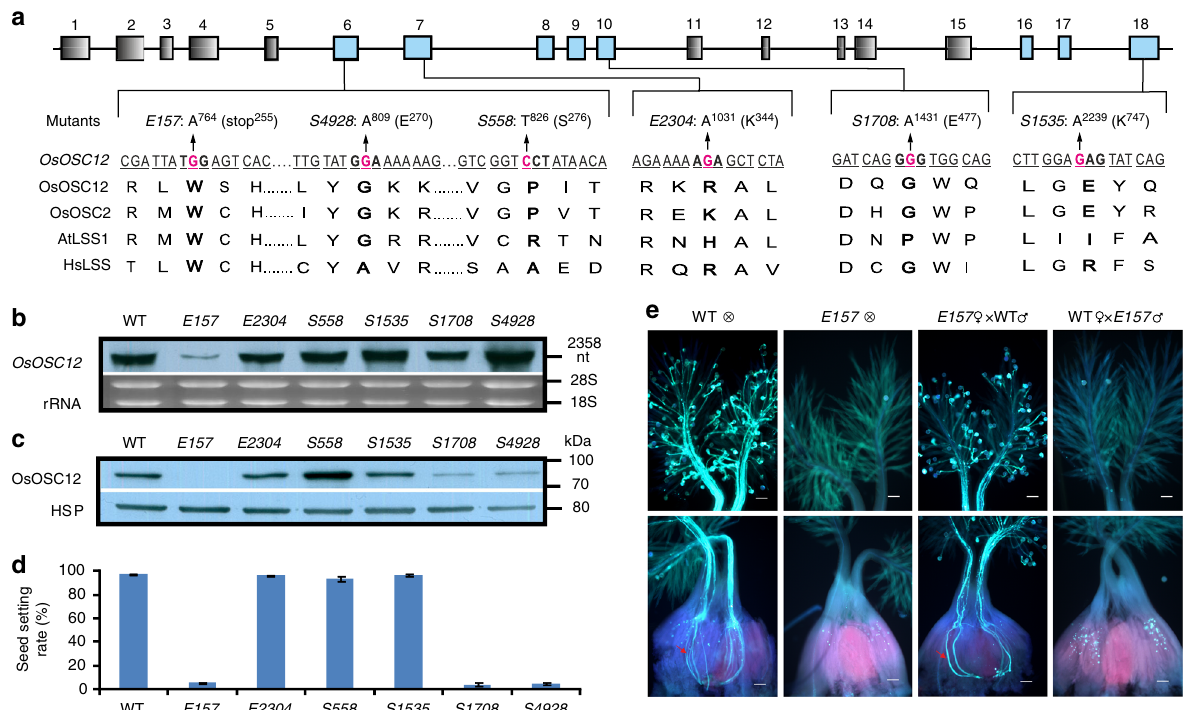
Fig. 2 The absence of OsOSC12 results in male sterility. a OsOSC12 mutants induced by either EMS or sodium azide. Boxes and lines indicate the OsOSC12 exons and introns, respectively. TILLING was directed at exons 6 – 10 and 16 – 18 (blue box). Mutated nucleotides are marked in red, and the changed nucleotides and the corresponding amino acids are shown for each mutant. b Northern blot analysis of OsOSC12 transcription. c Western blot analysis of OsOSC12 expression. Negative controls as given in Fig. 1. d Self fertility of fi eld-grown WT and mutant plants (30 – 39 °C, 40 – 70% RH), based on panicles. The data are presented as mean ± s.d. n = 15. e Germination (upper panel) and pollen tube elongation (lower panel) of WT and E157 pollen, imaged 1 h after pollination. Scale bar, 100 μ